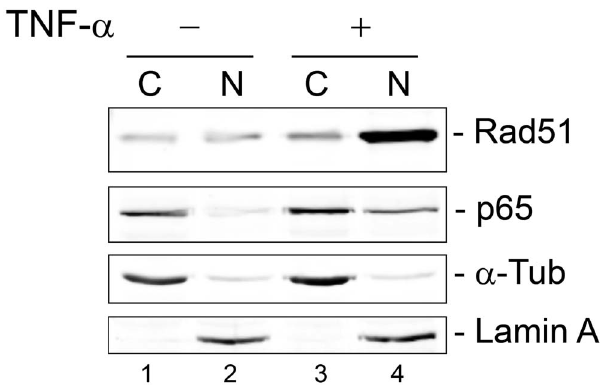
Figure 9. Effect of TNF- a on subcellular localization of NF- k B p65 and Rad51: Cell fractionation. TC620 cells were transfected with expression plasmids for p65 and Rad51, the next day serum- starved overnight and then either untreated or treated with 10 ng/ml TNF- a for 20 min and subject to cell fractionation as described in Materials and Methods.